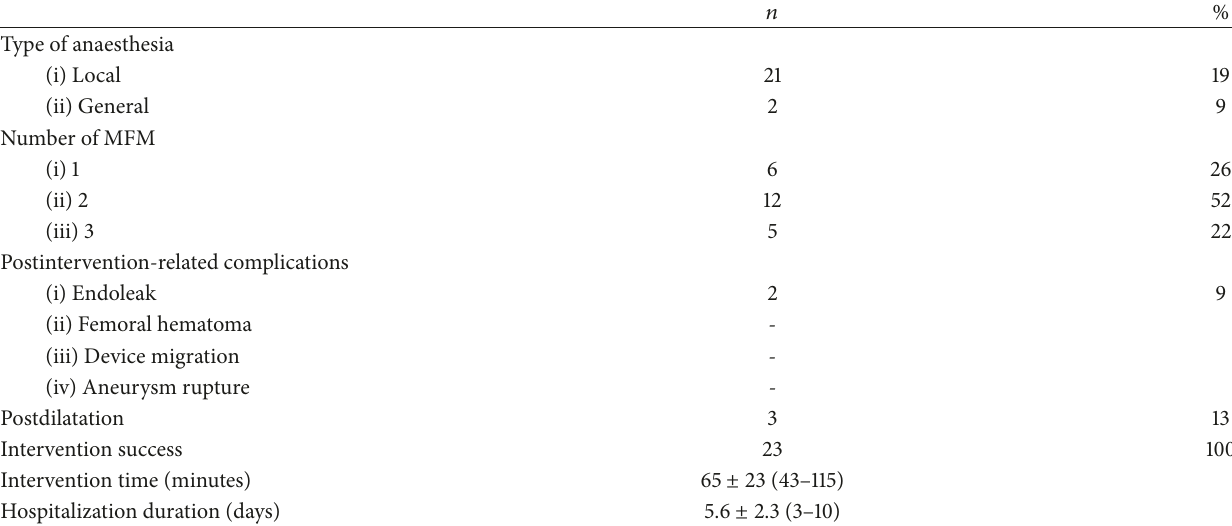
Figure 2: Female patient with advanced calcifications (porcelain aorta). Table 2: Intervention-related